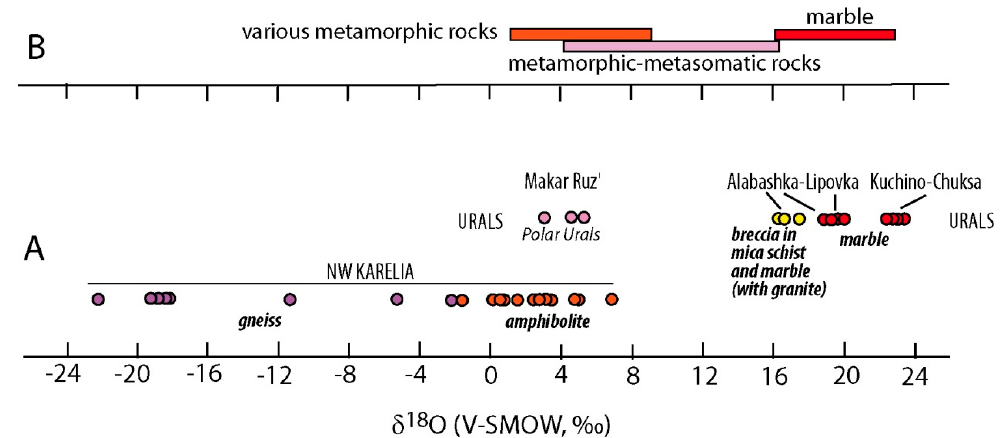
Figure 40. Oxygen isotopic composition of ruby from various Russian occurrences. ( A ) Oxygen isotopic composition of ruby in marble, breccia in mica schist and marble, and plagioclase-dominated metasomatic rocks from the Urals, and gneisses and amphibolites from northwest Karelia, Russia, modified from [153] and ( B ) the oxygen isotopic range of values for ruby worldwide associated with primary deposits [40,41,93,163].